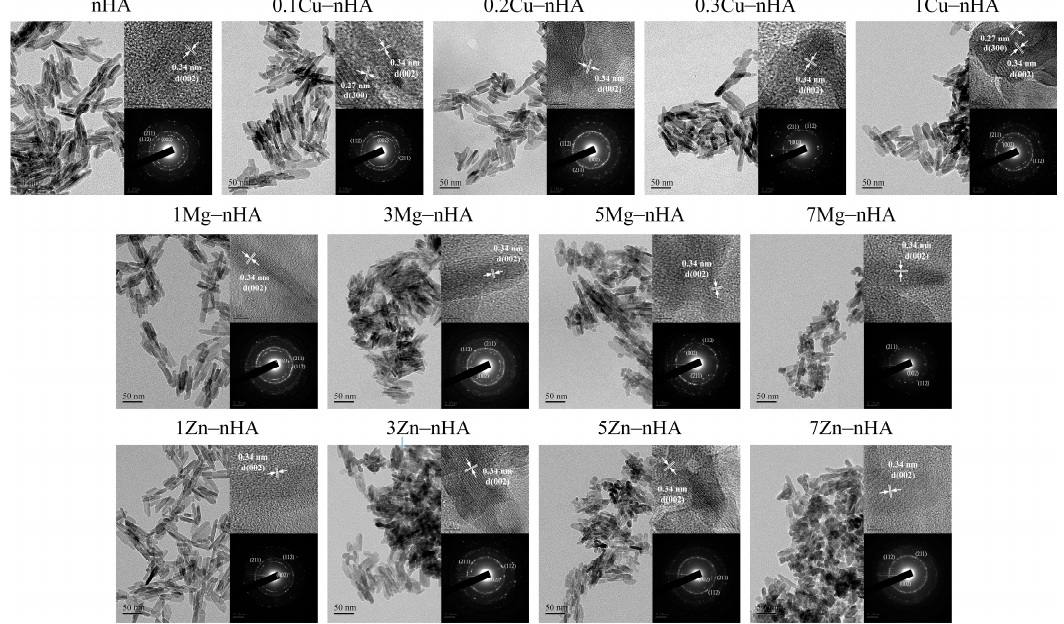
Figure 3. High-resolution transmission electron microscopy images, lattice images of the (002) facet of apatite were identified, and selected area electron diffraction analysis of rod-shape nanoapatites hydrothermal synthesized with different ionic co-precipitation concentrations in the absence (top left) and presence of Cu2+ (top row), Mg2+ (middle row), and Zn2+ (bottom row). Table 2. Average longitudinal length, transverse width, length-to-width aspect ratio ( n = 50) of rod-shaped nanoapatites and plane ratio of (002) to (300) FWHM values after doping in different Cu 2+ , Mg 2+ , and Zn 2+ ionic reaction